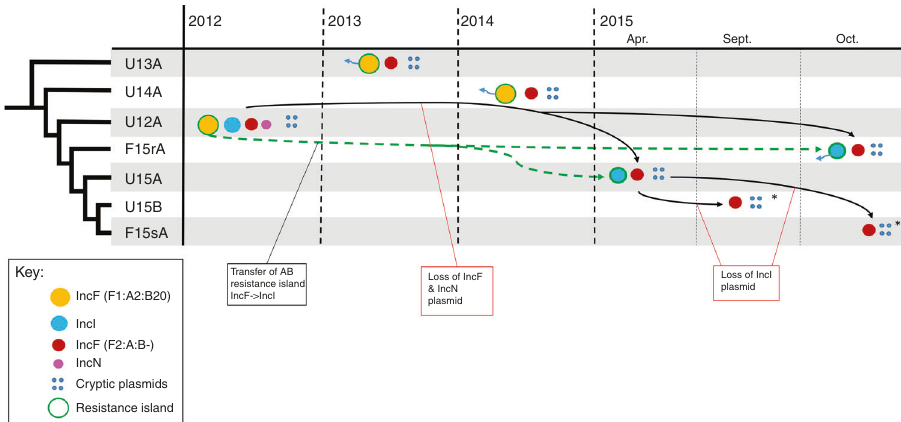
Fig. 3 Plasmid dynamics in Patient #1 isolates. Isolates are listed in the fi rst column in order of their phylogenetic relationship. The time line on the x axis indicates the approximate date of isolation of each strain. Black arrows indicate plasmid succession where directionality can be inferred from the single- nucleotide polymorphism pro fi le of Patient #1 isolates (Fig. 2). Green arrows represent the transfer of the antibiotic resistance island from the multidrug resistance IncF plasmid to the IncI plasmid. Blue arrows extending from resistance plasmids represent the loss of the Gentamicin resistance